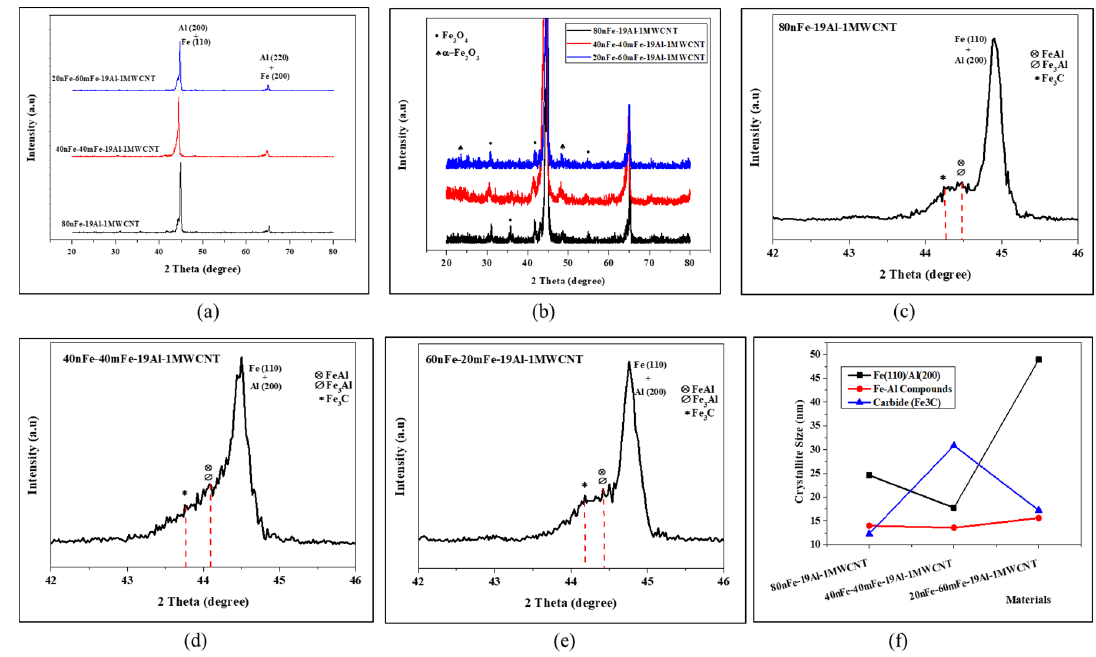
Figure 13. Effect of iron nanoparticles to iron microparticles volume ratio on crystallography: ( a ) full length of high intensity XRD peaks and ( b ) detailed view of low intensity peaks; ( c – e ) zoom of the major peak between 42 and 46° in XRD patterns for the composites and ( f ) crystallite size of some phases in the composites.